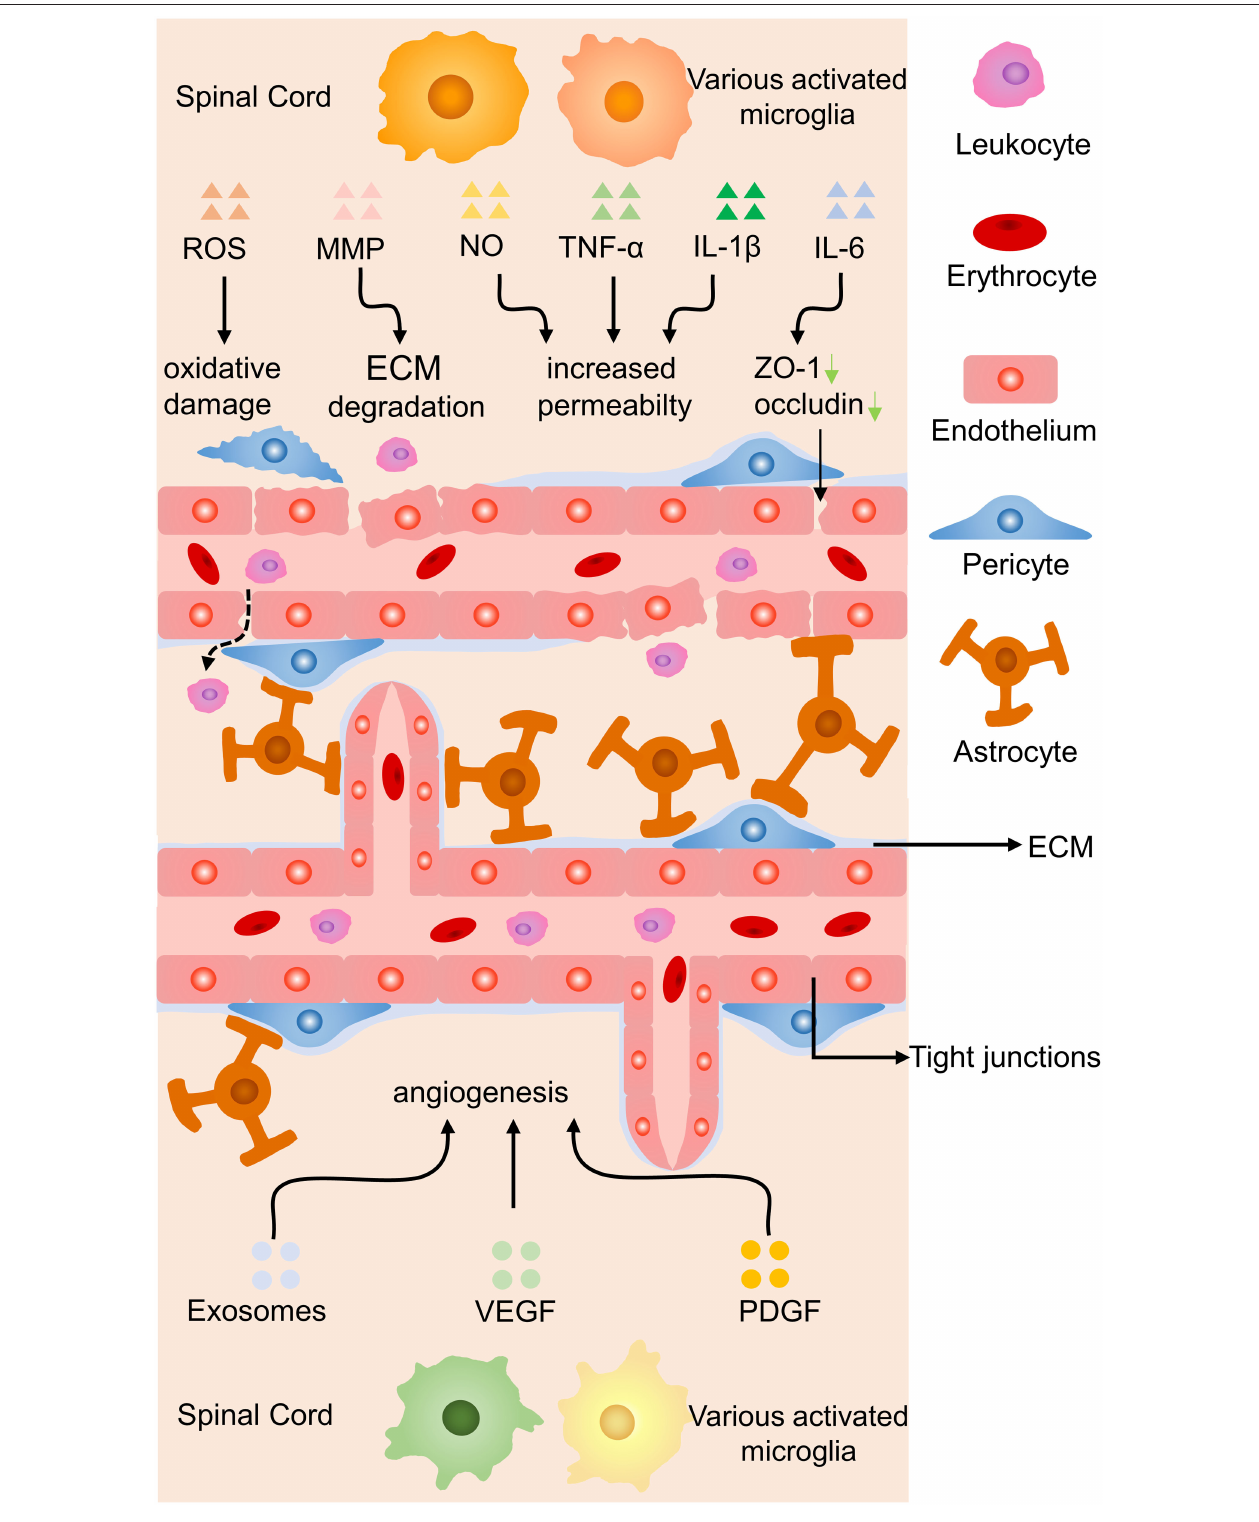
FIGURE 7 | Effects of microglia on endothelial cells in SCI. Proinflammatory cytokines induce oxidative damage to endothelial cells, ECM degradation, and increased permeability of the BBB by proinflammatory molecules, while anti-inflammatory secretion promotes angiogenesis. Green arrow, downregulation.